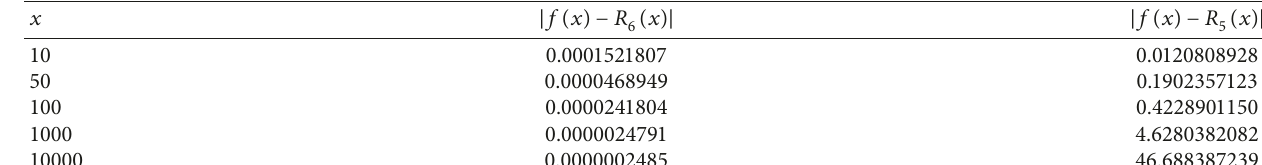
Table 6: Numerical experiments about the error.